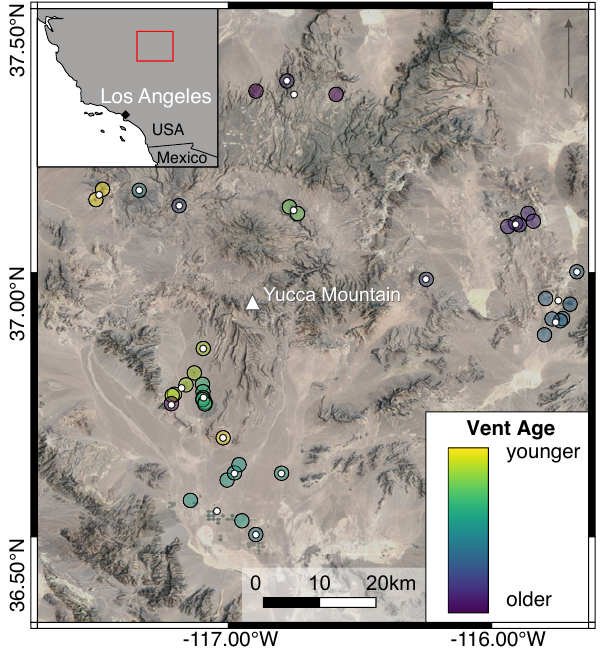
Figure 7: Map showing vent and event locations for the Yucca Mountain area, Nevada, USA (modified from Con- nor and Hill [1995]). The purple and yellow dots indicate the locations and relative ages of mapped vents, while the white dots show the location of calculated events. Map background data: Google,